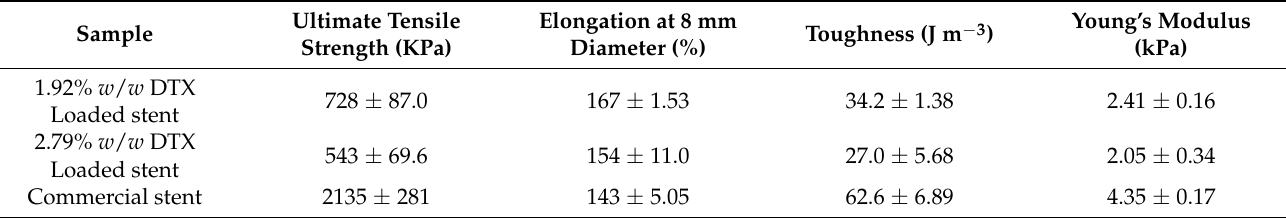
Figure 2. Stress–strain curve of ( A ) DTX-loaded 3D printed and ( B ) commercial stents. Table 1. Mechanical properties of commercial fully covered, and 1.92% w / w and 2.79% w / w DTX-loaded oesophageal stents ( n =